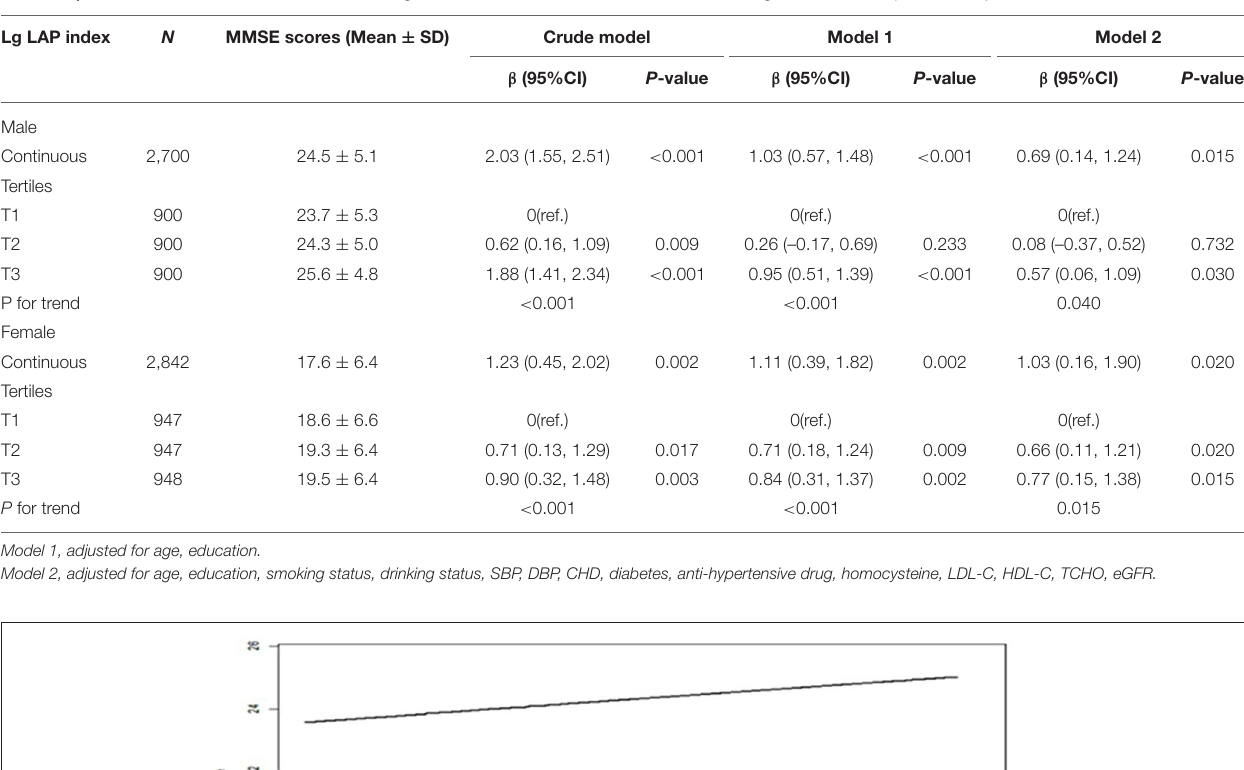
TABLE 2 | Association between LAP as a common logarithm-transformed continuous variable and cognitive function represented by MMSE scores.